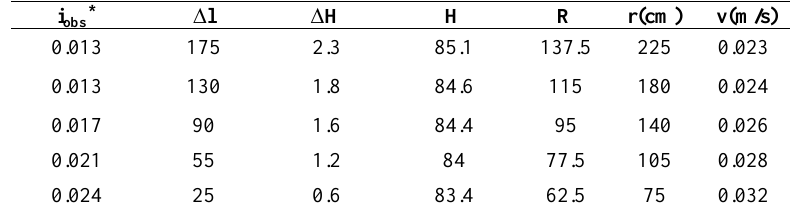
Table 5. i values measured by the Method II in the depth of 85 cm and level of 20 cm obs